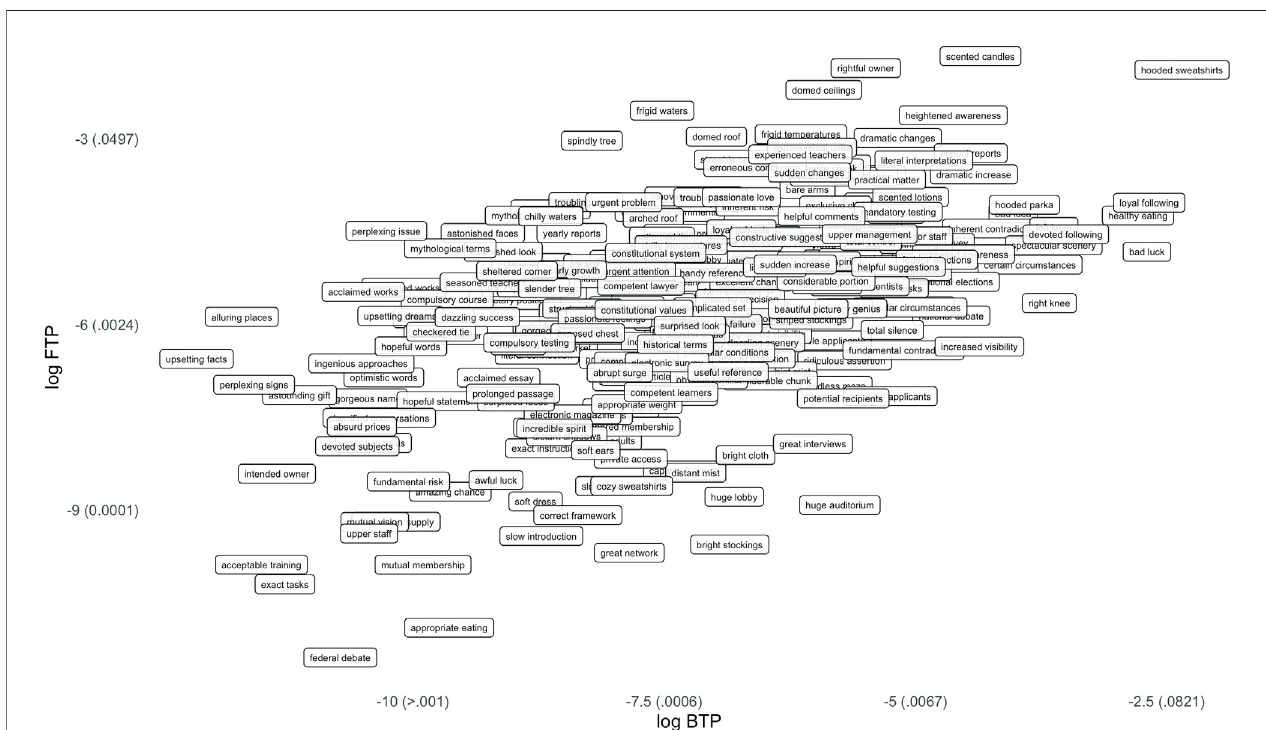
FIGURE 2 | Bigrams by log-transformed forward transition probability and log-transformed backward transition probability (approximate raw values in parentheses).